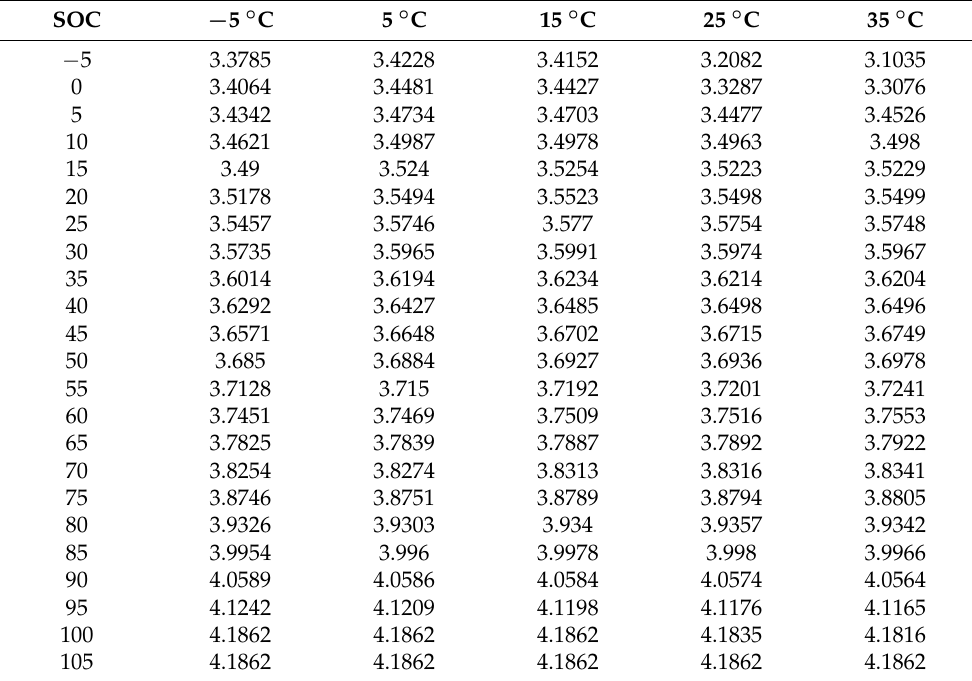
Table A6. Values for parameter OCV in V of electrical model shown in Figure 2 in dependence of cell temperature and